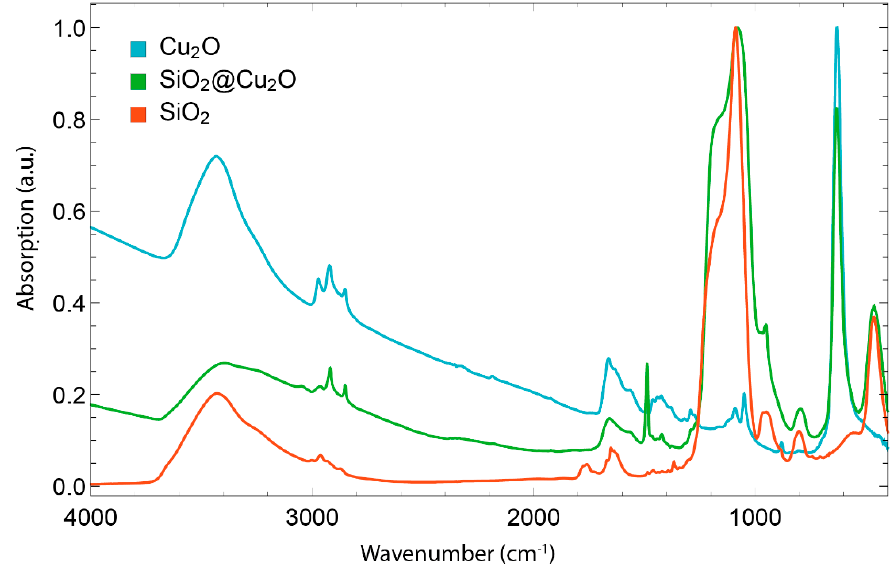
Figure 3. Infrared spectra of Cu2O cubes (Cyan), Cu2O@SiO2 core shell particles (green) and hollow SiO2 nanocubes (orange). All spectra are normalised such that the highest peak has an absorption of 1.